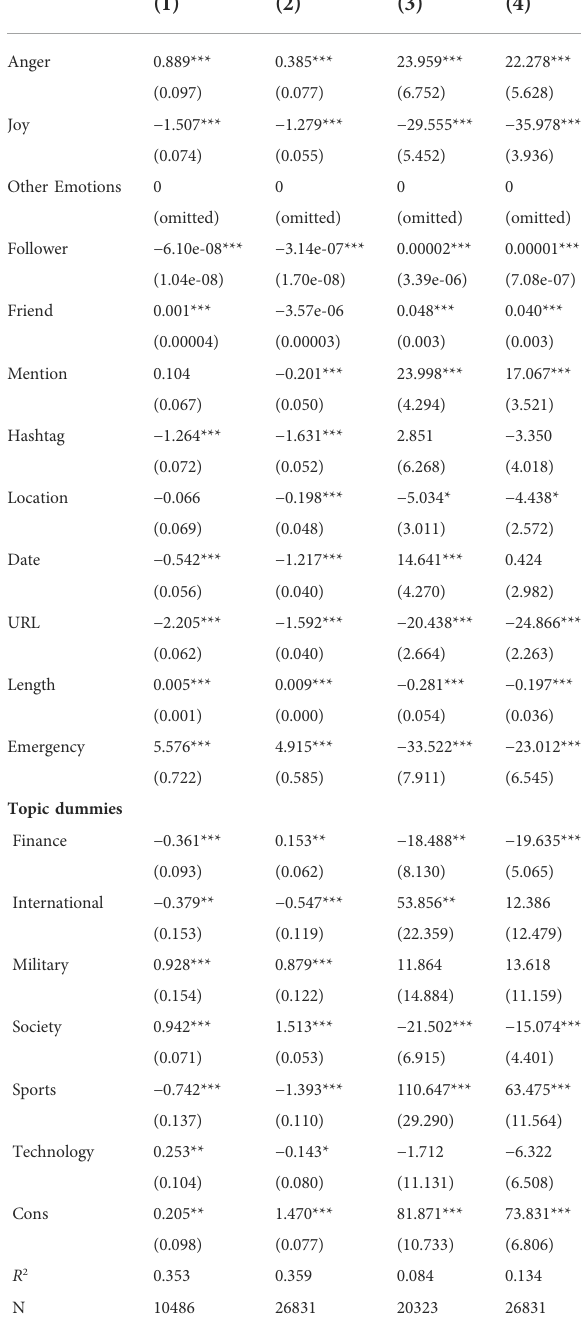
TABLE 2 The results of logit and linear models in different groups. (1) The results of the logit model in LT news and HF news. (2) The resultsofthelogitmodelinalltruenewsandfakenews.(3)Theresults of the linear model in LF news and HF news. (4) The results of the linear model in lowly retweeted (L) news and highly retweeted (H) news (see Supplementary Material S9 for more details). The values in brackets are the robust standard errors. * P < 0.1,** P < 0.05,*** P <